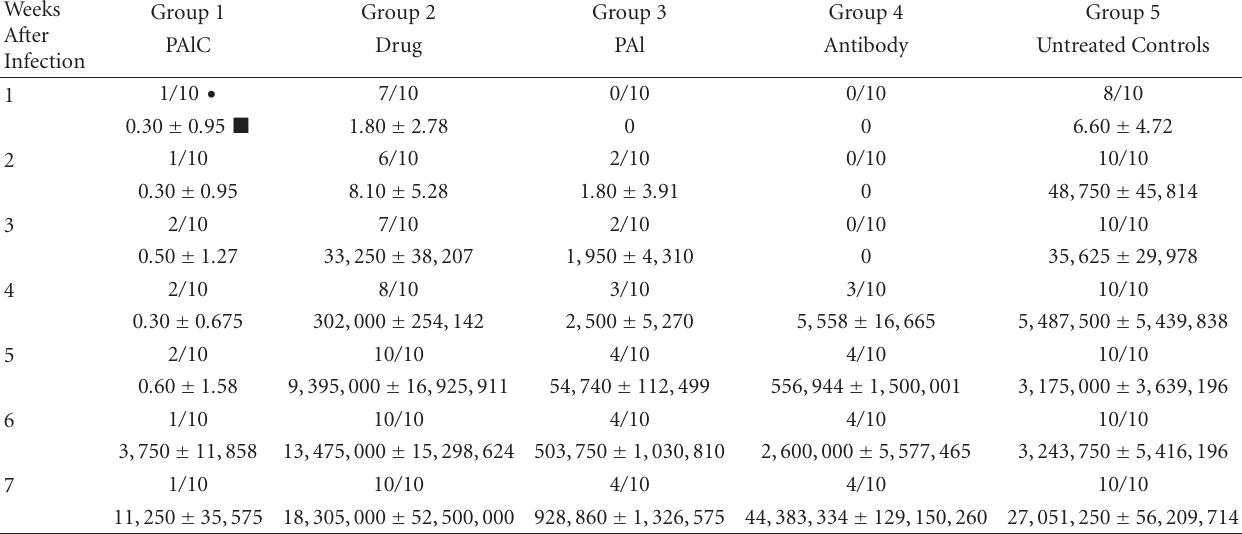
Table 1: Infectivity of Cryptobia salmositica to chinook salmon after in vitro exposure to isometamidium chloride to polyclonal antibodies from a recovered fish (reproduced from Ardelli and Woo [59]).